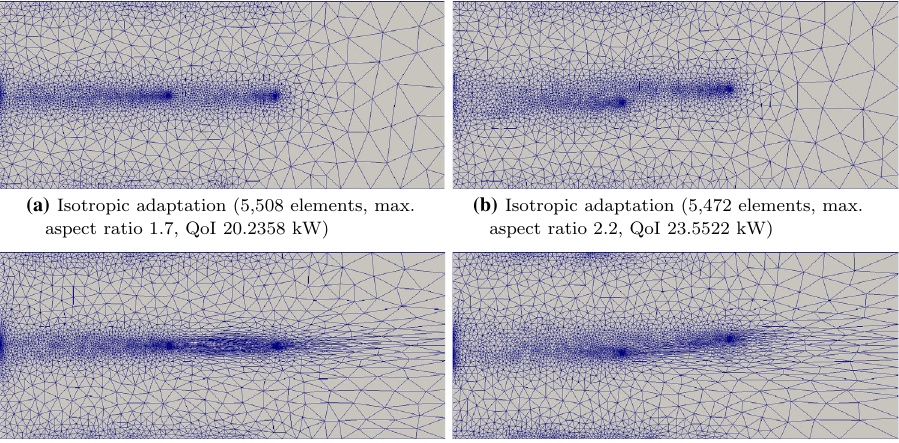
(c) Anisotropic adaptation (6,060 elements, max. aspect ratio 18.3, QoI 19.8468 kW)